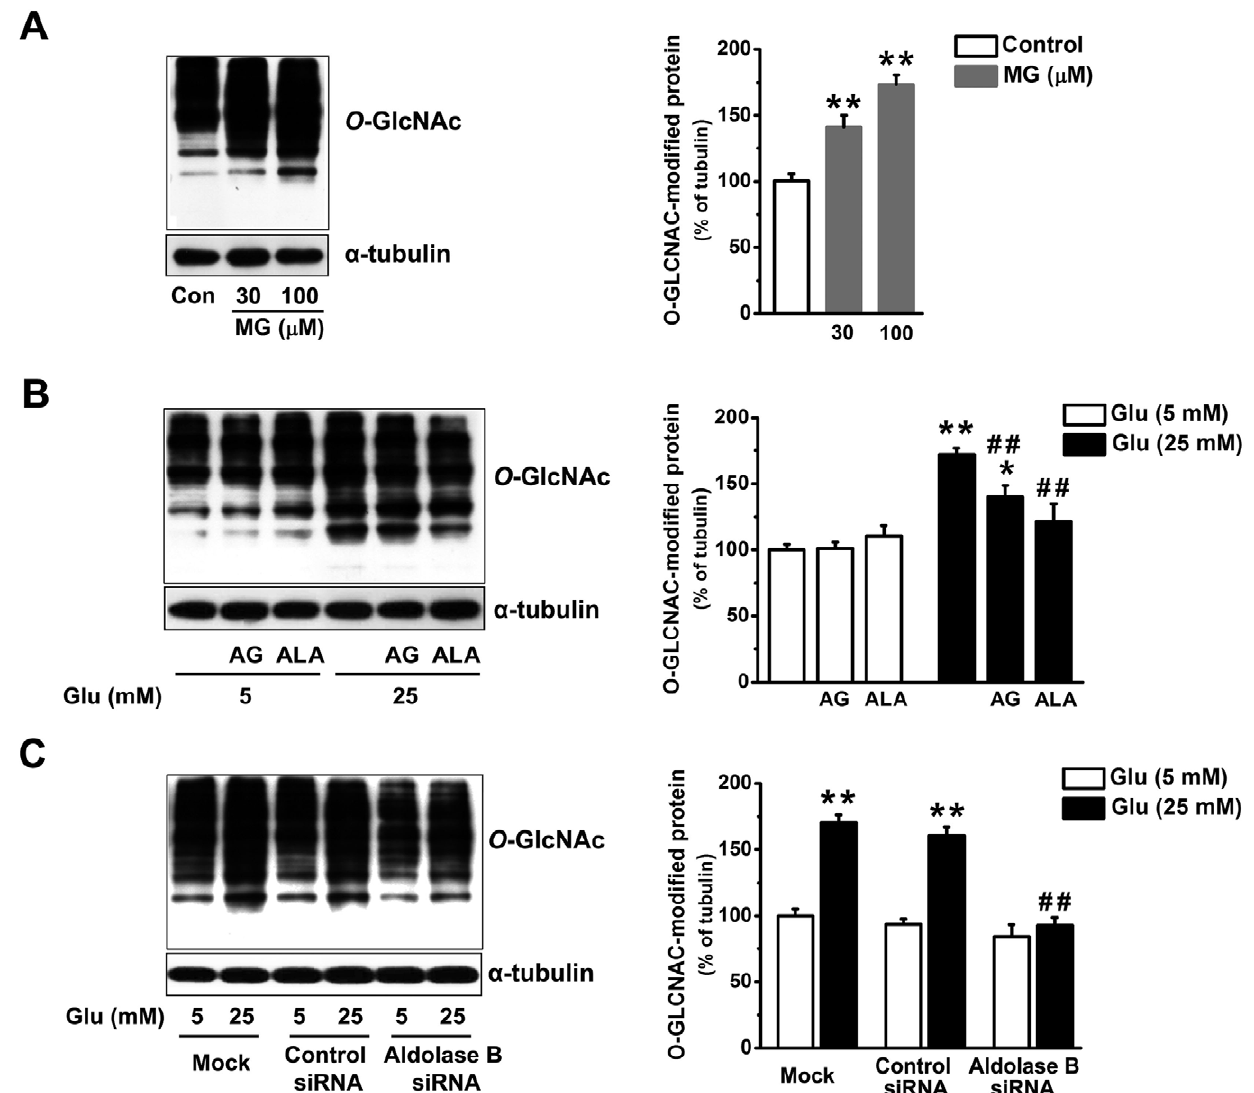
Figure 5. Knockdown of aldolase B prevented high glucose-increased O-linked N-acetyl glucosamine ( O -GlcNAc) modification in EA. hy926 cells. (A) O -GlcNAc modification of total cellular proteins in cells treated with exogenous MG for 3 days. ** P , 0.01 vs . control (5 mM glucose). (B) O -GlcNAc modification of total cellular proteins in cells treated with glucose (Glu) in the presence or absence of aminoguanidine (AG, 1 mM) and alagebrium (ALA, 100 m M). * P , 0.05, ** P , 0.01 vs . 5 mM glucose; ## P , 0.01 vs. 25 mM glucose. (C) O -GlcNAc modification of total cellular proteins in cells transfected with control or aldolase B siRNA, or only transfection agent (mock). ** P , 0.01 vs . 5 mM glucose; ## P , 0.01 vs . control